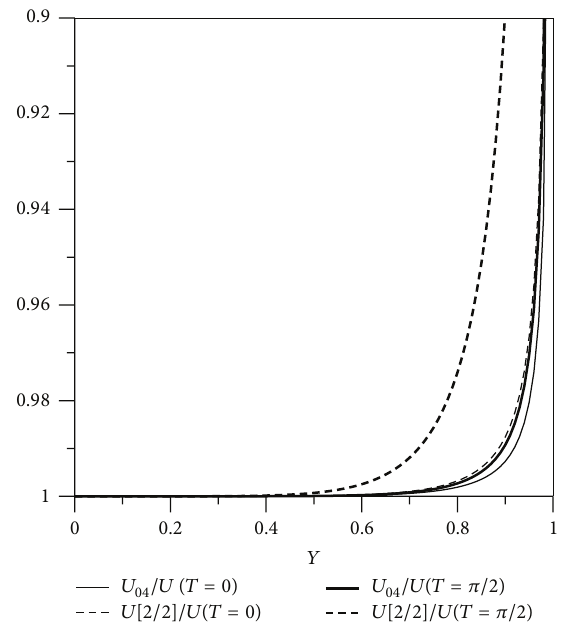
Figure 3: Ratios of polynomial solution and its Pad´e [2,2] approxi- mation to the exact solution for pressure-driven pulsating